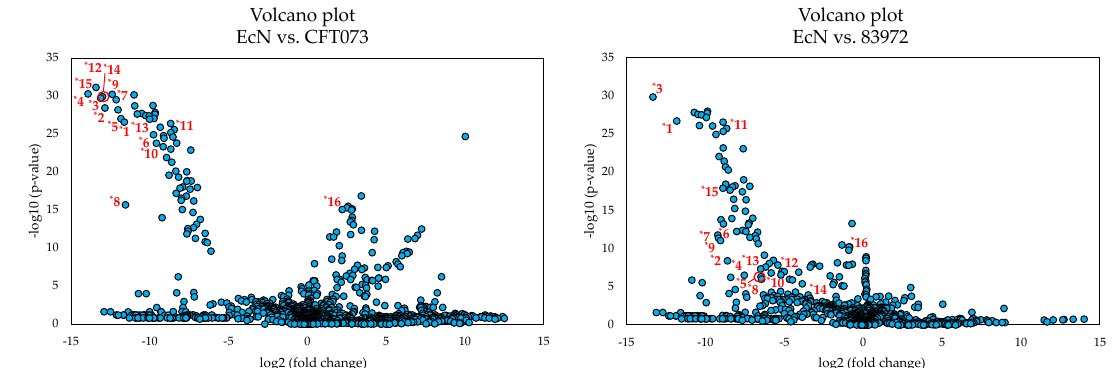
Figure 3. The volcano plots of the univariate statistical analysis of the metabolome of the E. coli strains EcN vs. CFT073 and EcN vs. 83972 cultivated in MEM for 6 h. Three biological replicates of each strain were analyzed in triplicate. The labeled numbers of the features correspond to the features of Table